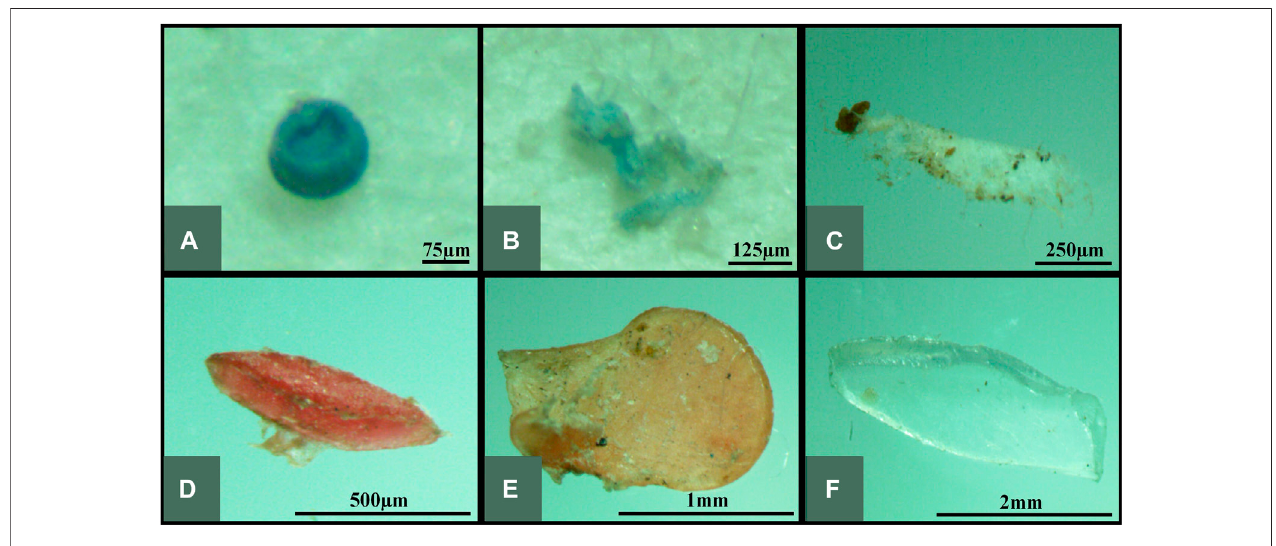
FIGURE7| Photographsofdifferentsizesofmicroplasticscollectedfromthesurfacewaterandsedimentsamples – (A) 75 – < 125 µm, (B) 125 – < 250 µm, (C) 250 – < 500 µm, (D) 500 – < 1000 µm, (E) 1 – < 2.36 mm, and (F) 2.36 – < 5 mm.